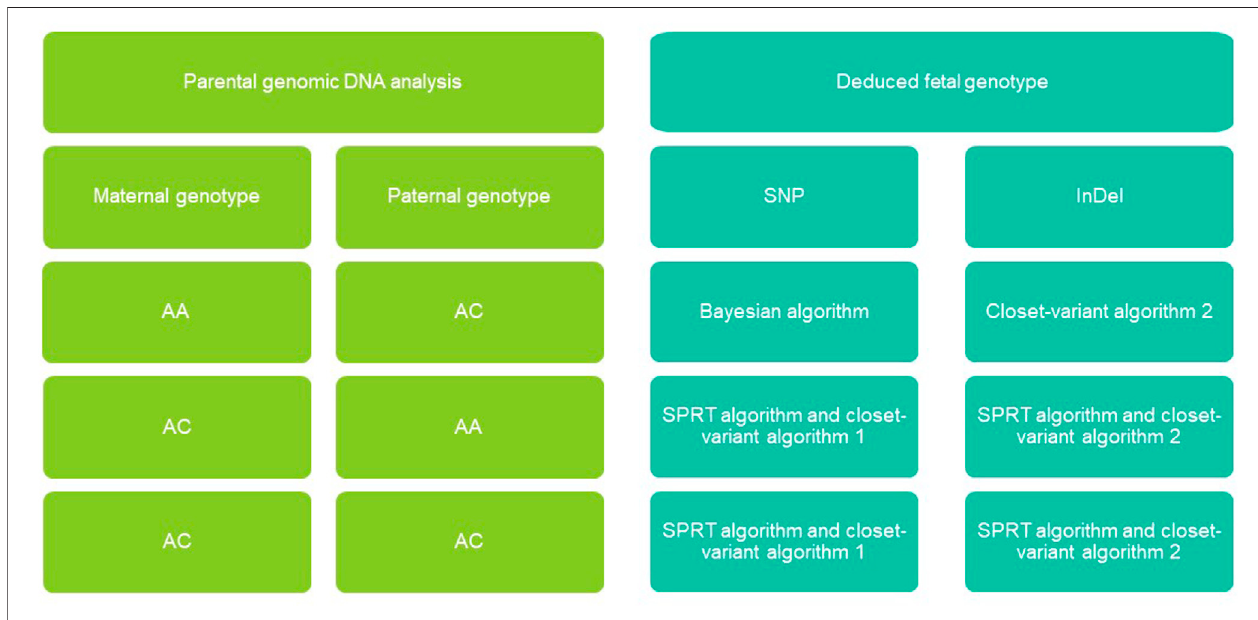
FIGURE2| Non-invasivefetalgenomicanalysisbasedoncell-freeDNAinmaternalplasma.Parentalcombinationsofsingle-nucleotidepolymorphisms(SNVs)and insertions-deletions (InDel) were grouped into four types, each of which we predicted using a different strategy (see Methods). AA, homozygous; AB, heterozygous; SPRT, sequential probability ratio testing.